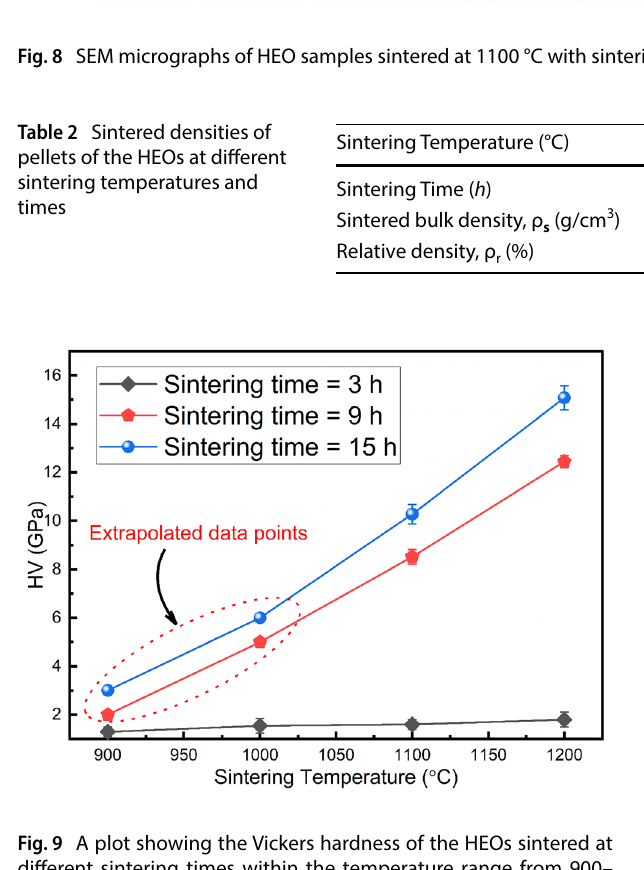
Fig. 9 A plot showing the Vickers hardness of the HEOs sintered at different sintering times within the temperature range from 900– 1200